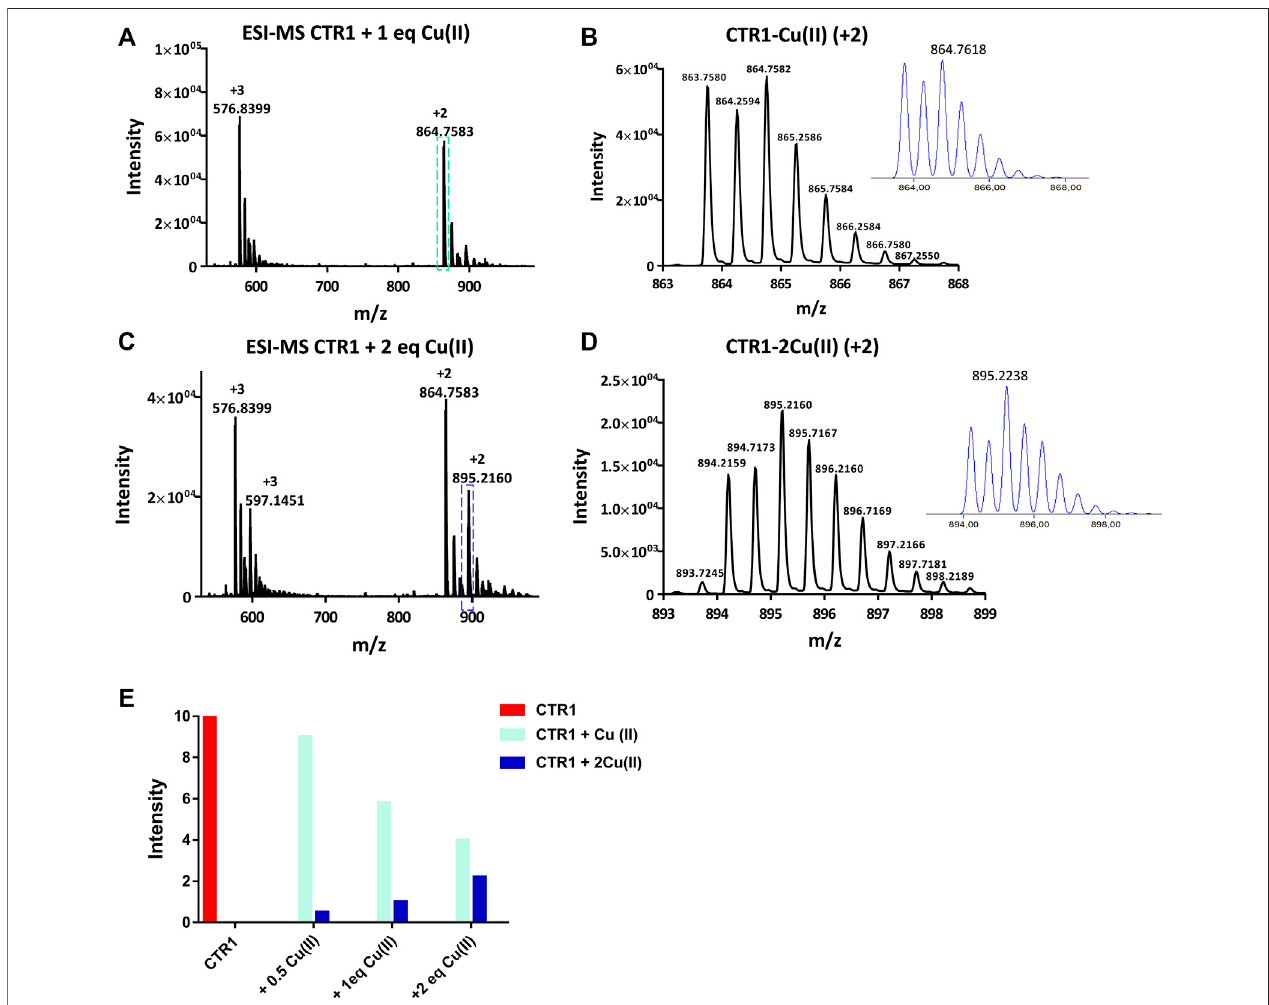
FIGURE 4 | ESI-MS spectra of Ctr1 1-14 treated with 1 and 2 eq of CuSO 4 (A,C) and magni fi cation of the doubly charged peaks ( cyan and blue dashed boxes ) displayed in (B,D) , respectively; the insets show the calculated isotopic distributions. (E) Intensity of doubly charged ESI-MS peaks of different Ctr1 1-14 species as a function of Cu(II):peptide ratio.